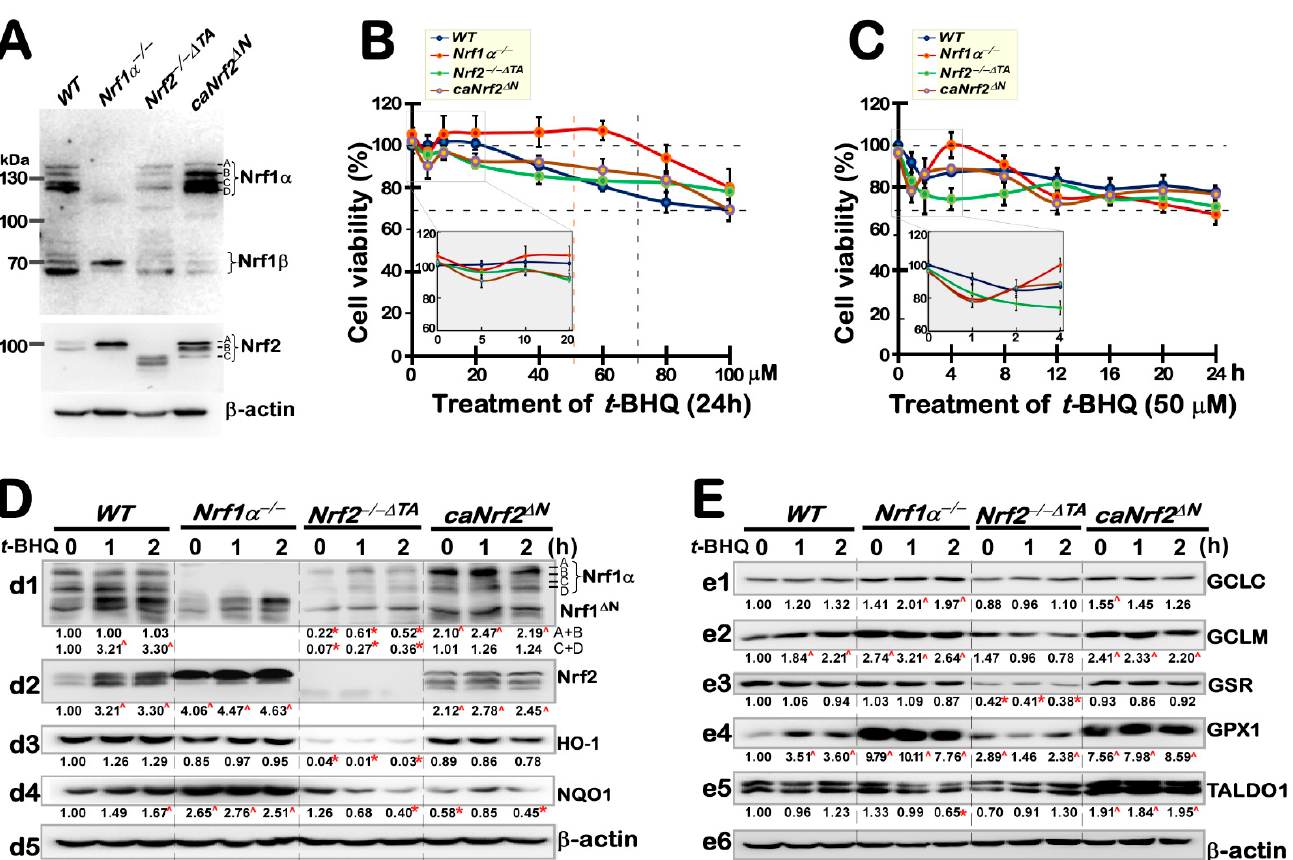
Figure 1. Distinct effects of t BHQ on different cell viability and antioxidant responsive genes. ( A ) Distinct protein abundances of Nrf1 and Nrf2 isoforms in WT , Nrf1 α − / − , Nrf2 − / −Δ TA , or caNrf2 Δ N cell lines were determined by Western blotting with their specific antibodies. ( B , C ) Different cell viability was examined by the MTT-based assay, after the indicated cells had been treated with t BHQ: ( B ) at different doses (from 0 to 100 μ M) for 24 h; ( C ) at a single dose of 50 μ M for different lengths of time. The MTT assay was repeated three times, each performed in at least quintuplicates. The expanded graphic areas (at 0 to 20 μ M between 0 and 4 h) were placed in the interior windows. ( D , E ) Four distinct cell lines were or were not treated with 50 μ M t BHQ for a short time (from 0 to 2 h), followed by western blotting of Nrf1 ( d1 ), Nrf2 ( d2 ) and other ARE-driven target gene products as indicated ( d3 , d4 and e1–e5 ). The intensity of immunoblots was calculated at the gray values listed under the corresponding protein bands with statistical analysis of significant increases (^, p < 0.01) and significant decreases (*, p < 0.01) in their expression levels. These data shown herein are representative of at least three independent experiments.